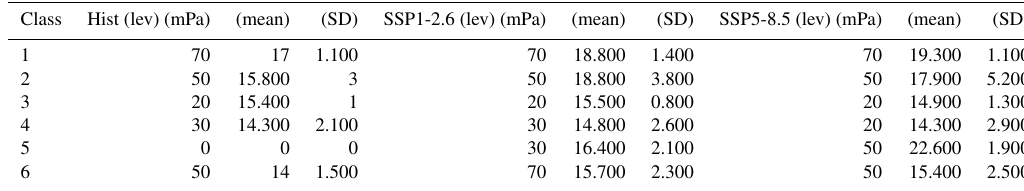
Table D3. The same as Table D1 but for JJA.